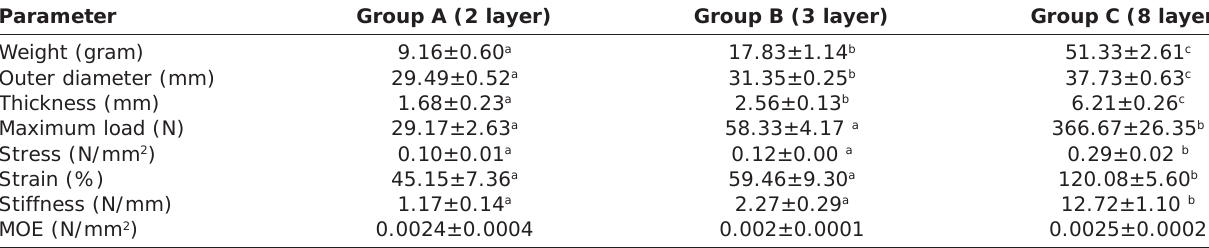
Table-1: Mean±SE values of physical and mechanical parameters of different layer of POP